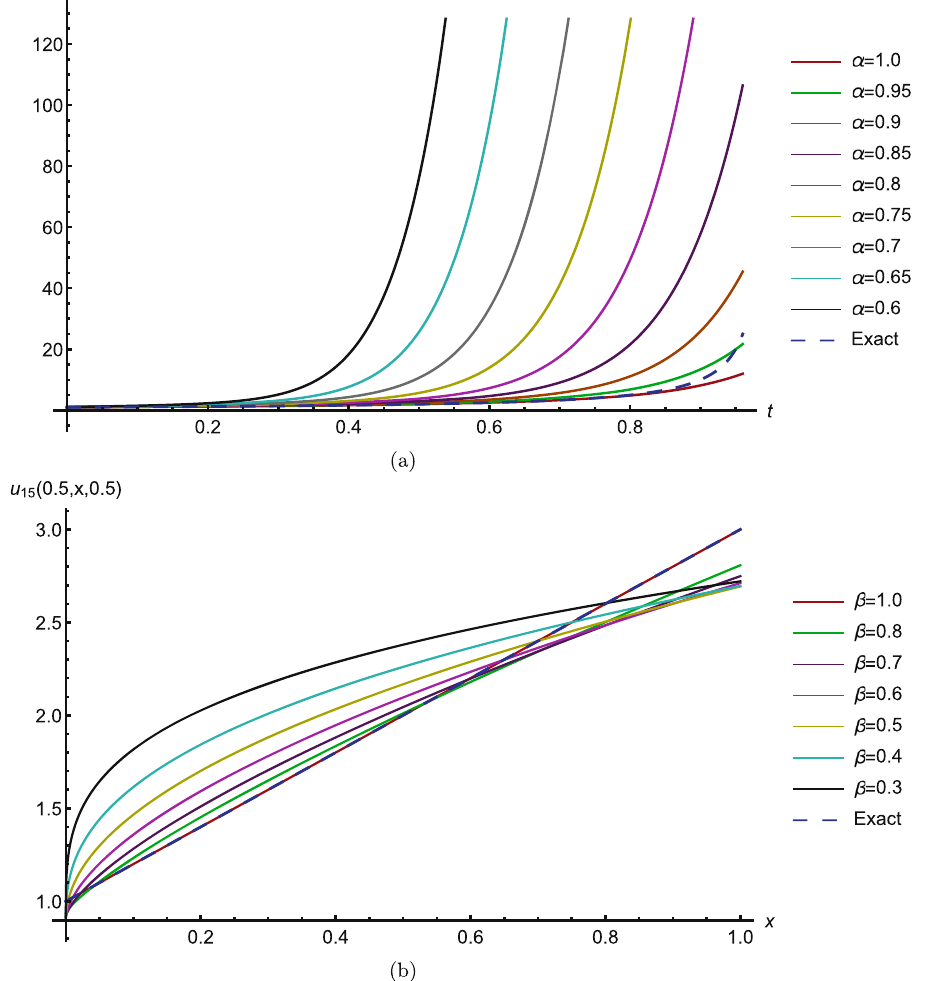
Figure 3: The cross - section behavior of u t x y , , 10 ( ) for ( 3.11 ) at various values of α β γ , , ∈ ( 0,1 ) . ( a ) β γ 1 = = . ( b ) α γ 1 = =